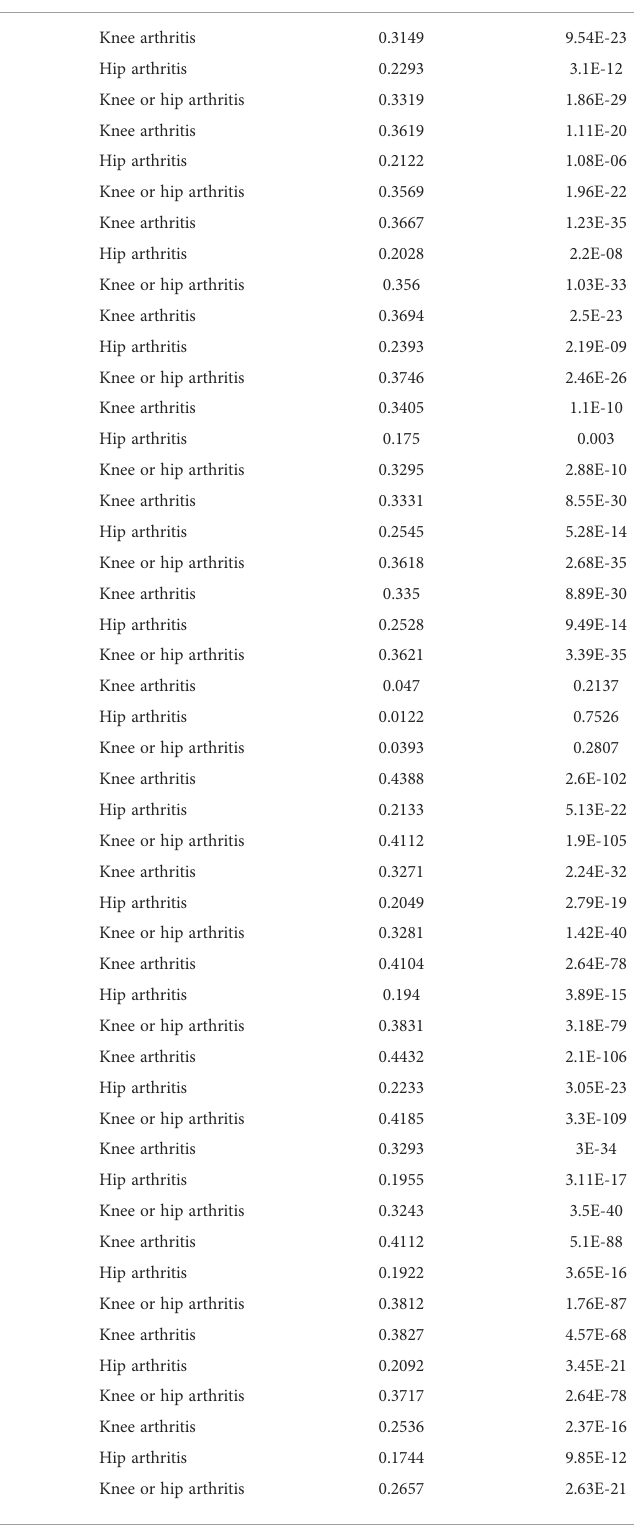
TABLE 3 Genetic correlation between obesity related anthropometric indicators and body compositions and knee and hip arthritis. Obesity related anthropometric indicators and body